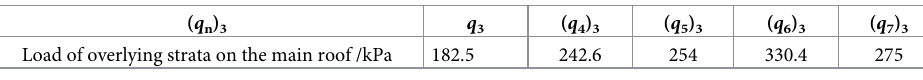
Table 8. A load of overburden strata on the main roof of No.12 -1 coal seam.